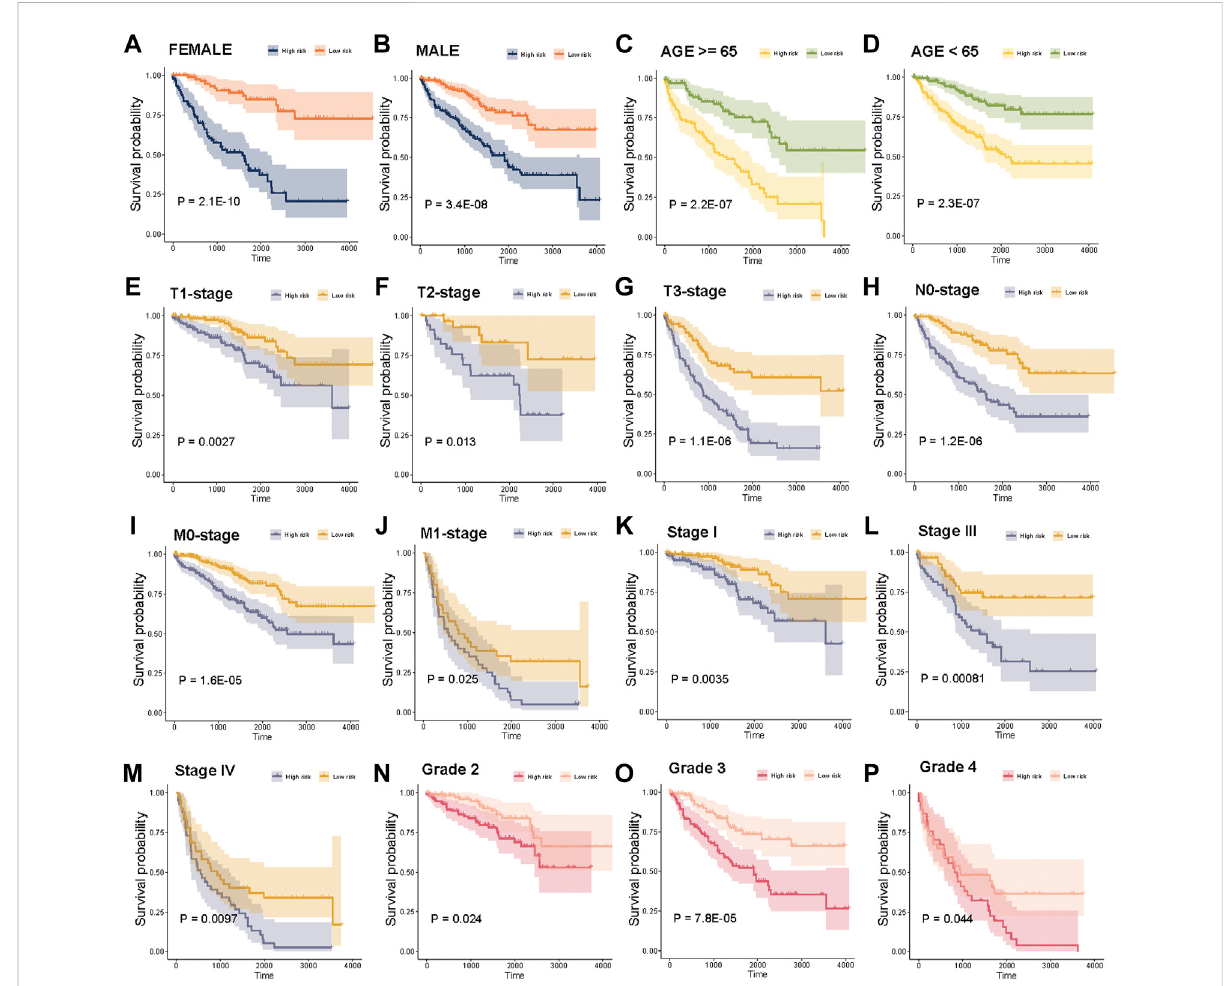
FIGURE 6 Strati fi cation analysis of the risk score in clinical subgroups. (A) – (P) Survival analysis for high risk score and low risk score patients in sex, age, T-stage, N-stage, M-stage, tumor stage, and tumor grade